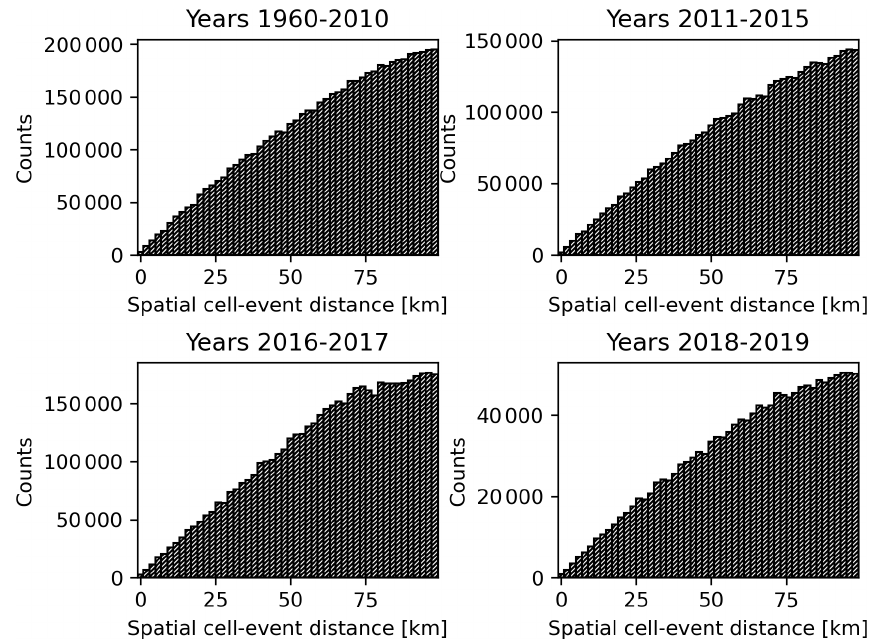
Figure 3. Histograms of the distances between every spatial cell and event pair (spatial cell-event distances) of the CPTI15 Italian earthquake catalog at different time periods.